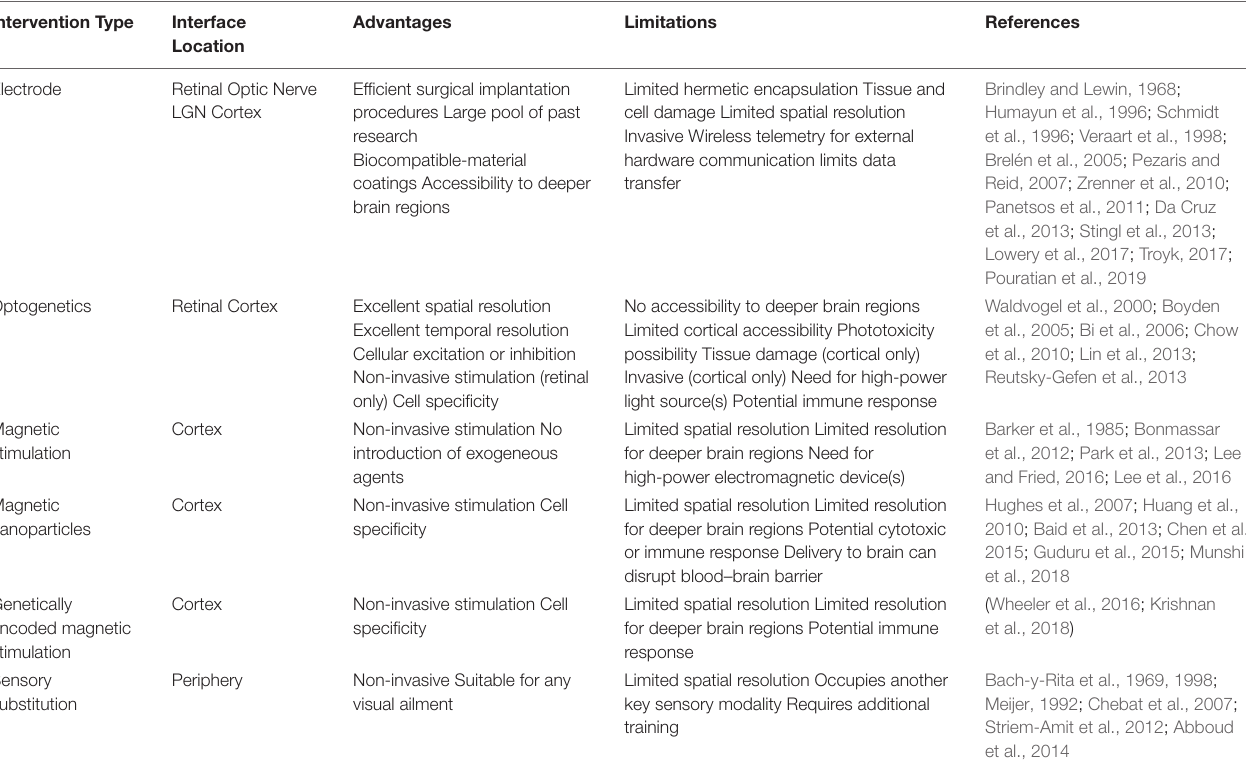
TABLE 1 | Advantages and limitations of different visual prostheses modalities with feasible interface locations. Intervention